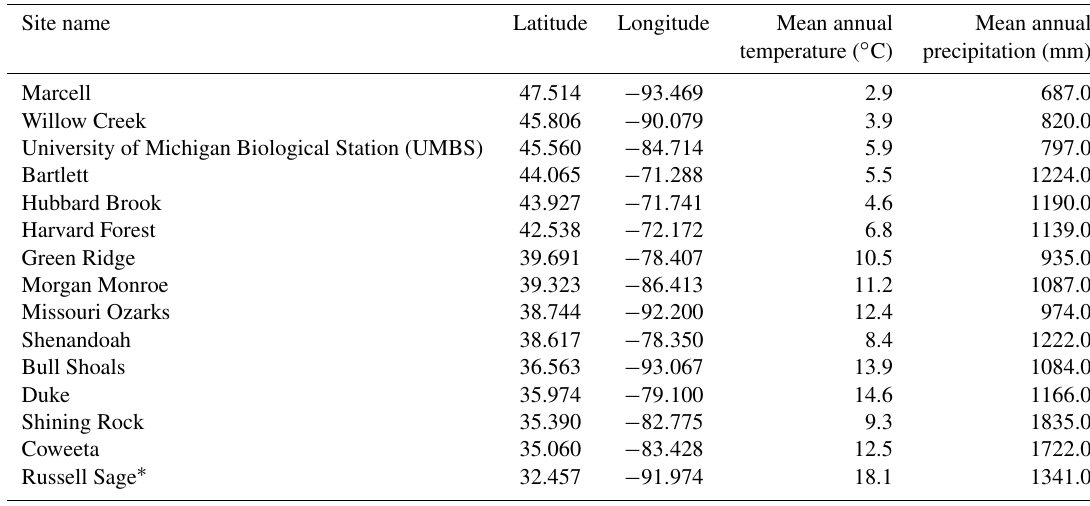
Table 1. Characteristics of selected sites including the coordinates and some climate data from WorldClim (Hijmans et al., 2005), which were assessed from the PhenoCam website (https://phenocam.sr.unh.edu/webcam/, last access: 1 July